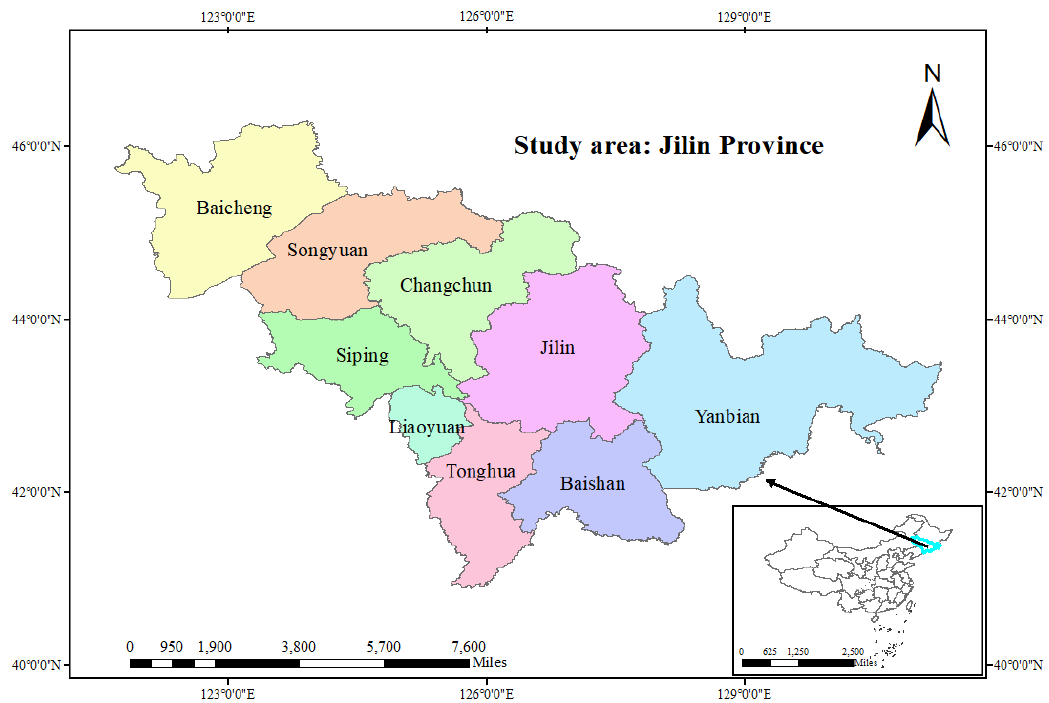
Figure 1. Location of Jilin Province.